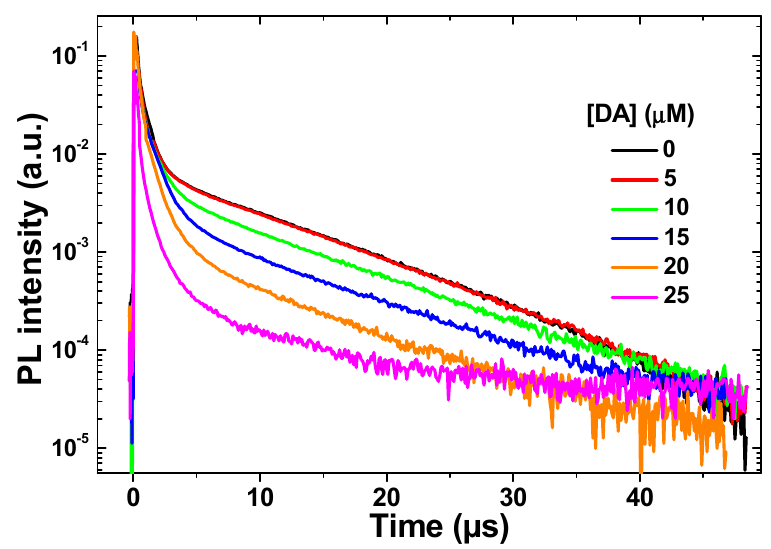
Figure 4. Time-resolved luminescence of QDs@MIP vs DA concentration measured at 550 nm. Table 1. Time constants τ 1 and τ 2 of QDs@MIP particles vs DA concentration.